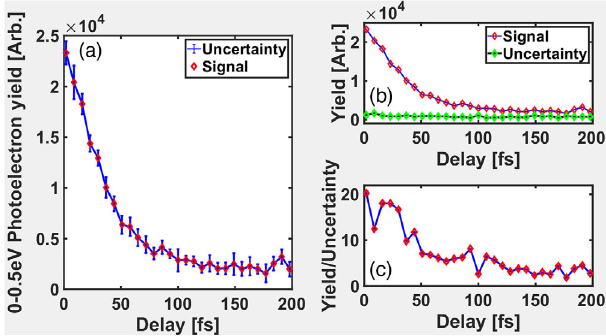
FIG. 10. TRPES for Xe used to determine time zero. FIG. 11. Uncertainty analysis of low-energy photoelectron yield. Panel (a) shows the photoelectron yield as a function of pump-probe delay for electrons below 0.5 eV, along with the uncertainty (error bars), which is given by the standard deviation from the bootstrapping analysis. Panel (b) shows the yield and uncertainty as separate curves as a function of delay. Panel (c) shows the ratio of the yield and uncertainty, demonstrating a signal-to-noise ratio of greater than 5 over the relevant range of delays.